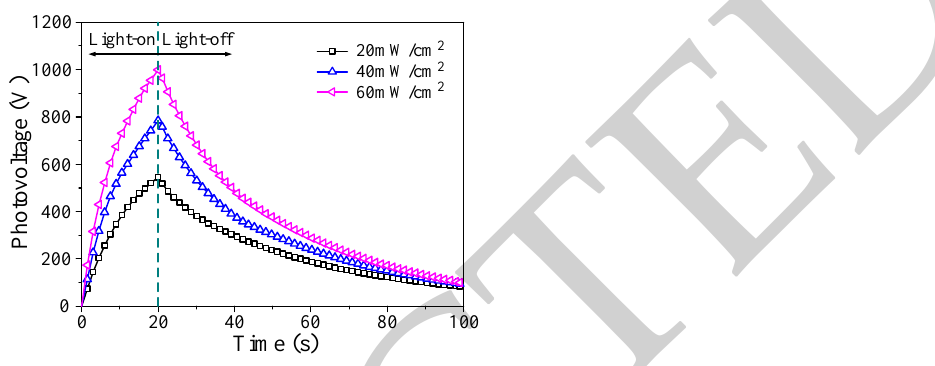
Figure 3. Time history of the photovoltage of PLZT under irradiation of different light intensities. Based on the experimental data of the photovoltage under irradiation of 20 mW/cm 2 , 40 mW/cm 2 , and 60 mW/cm 2 , the fitting value of V S , τ , V 0 , A 1 , A 2 , τ d1 , τ d2 can be identified through Equations (1) and (3). When the light intensity is 20 mW/cm 2 , the photovoltage of